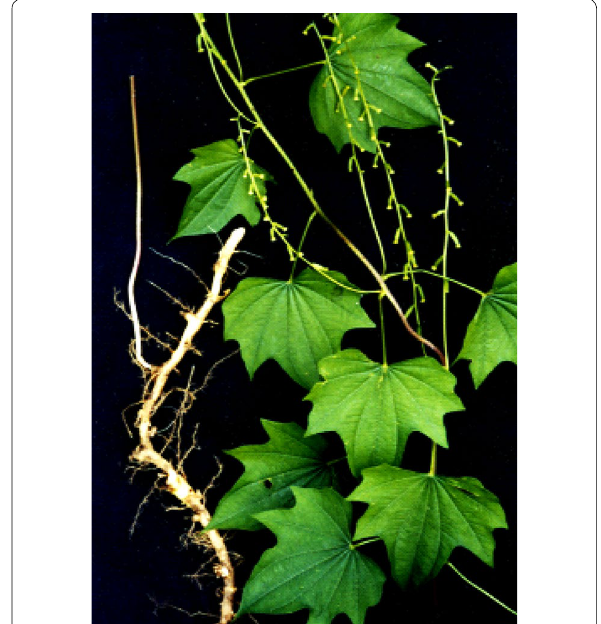
Fig. 3 Photo of the plant of D.